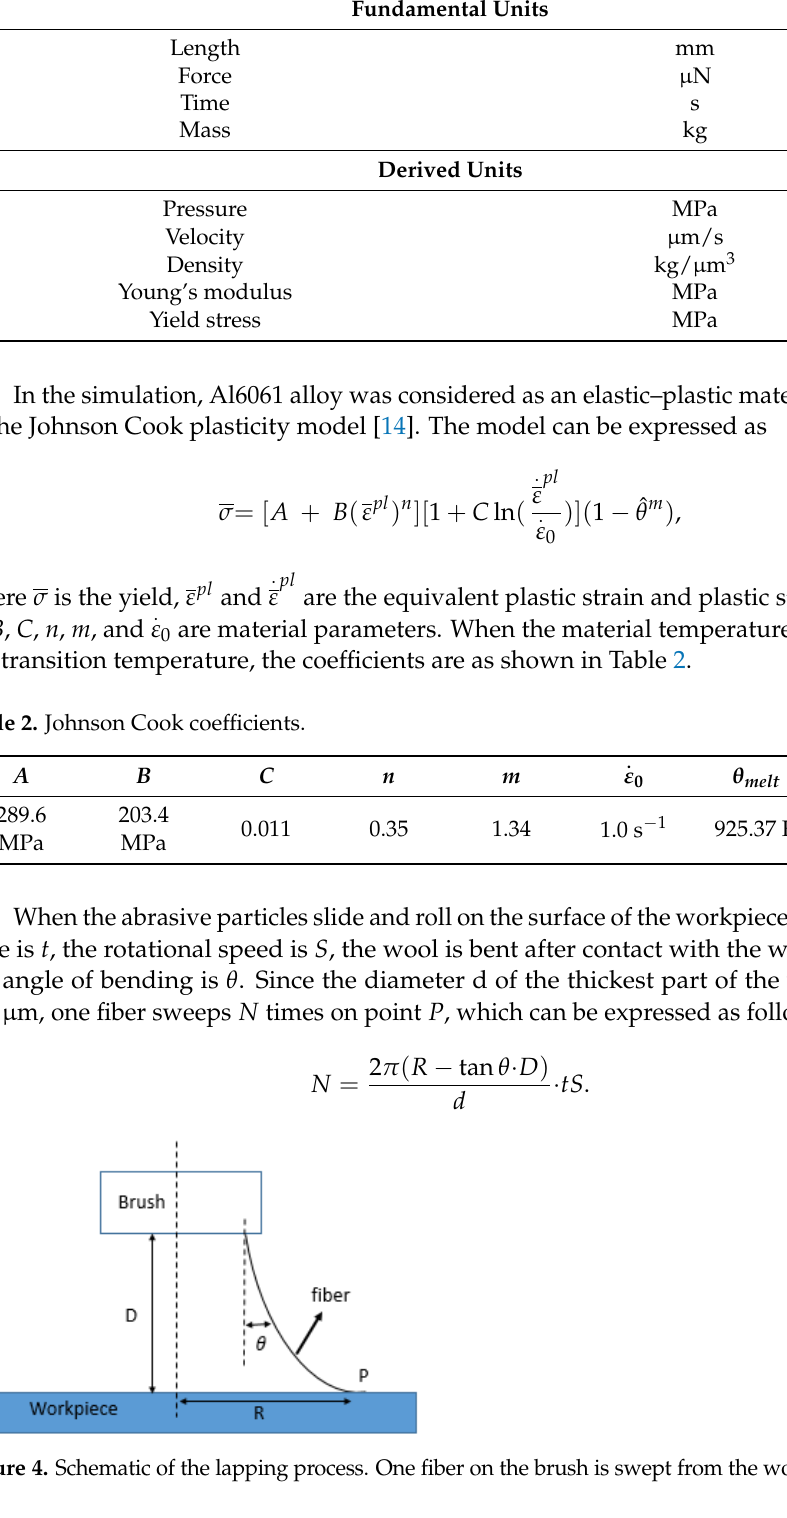
Table 1. Units used in the simulation. Fundamental Units Length